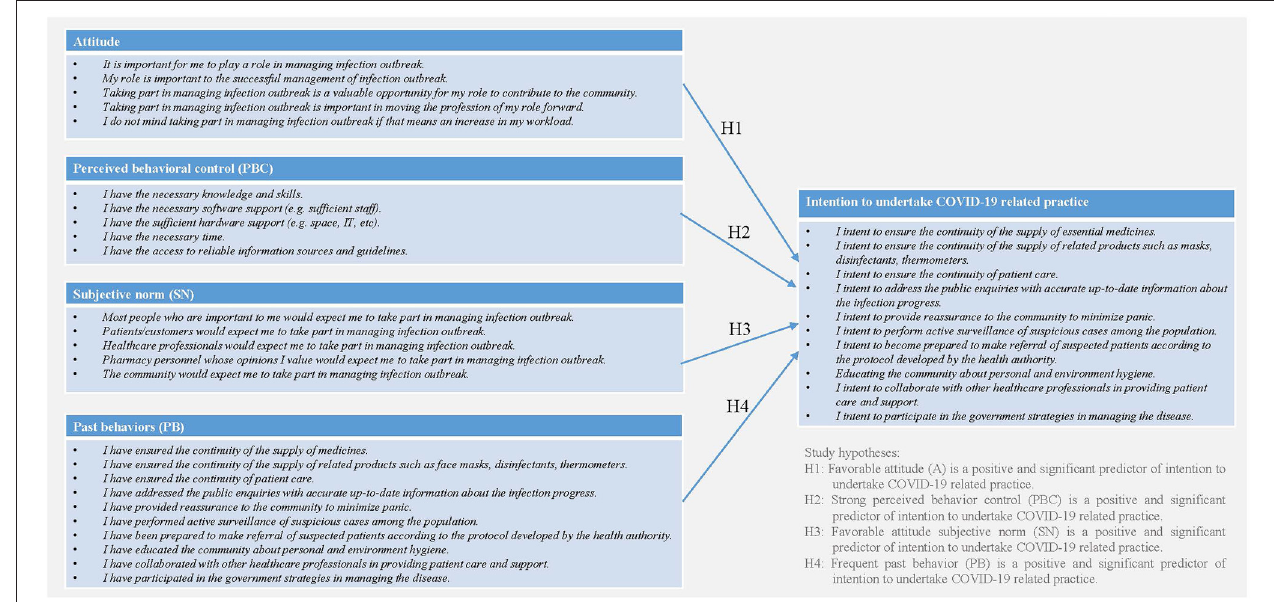
FIGURE 1 | Research model of pharmacists’ intension to undertake COVID-19 related practice based on the theory of planned behavior